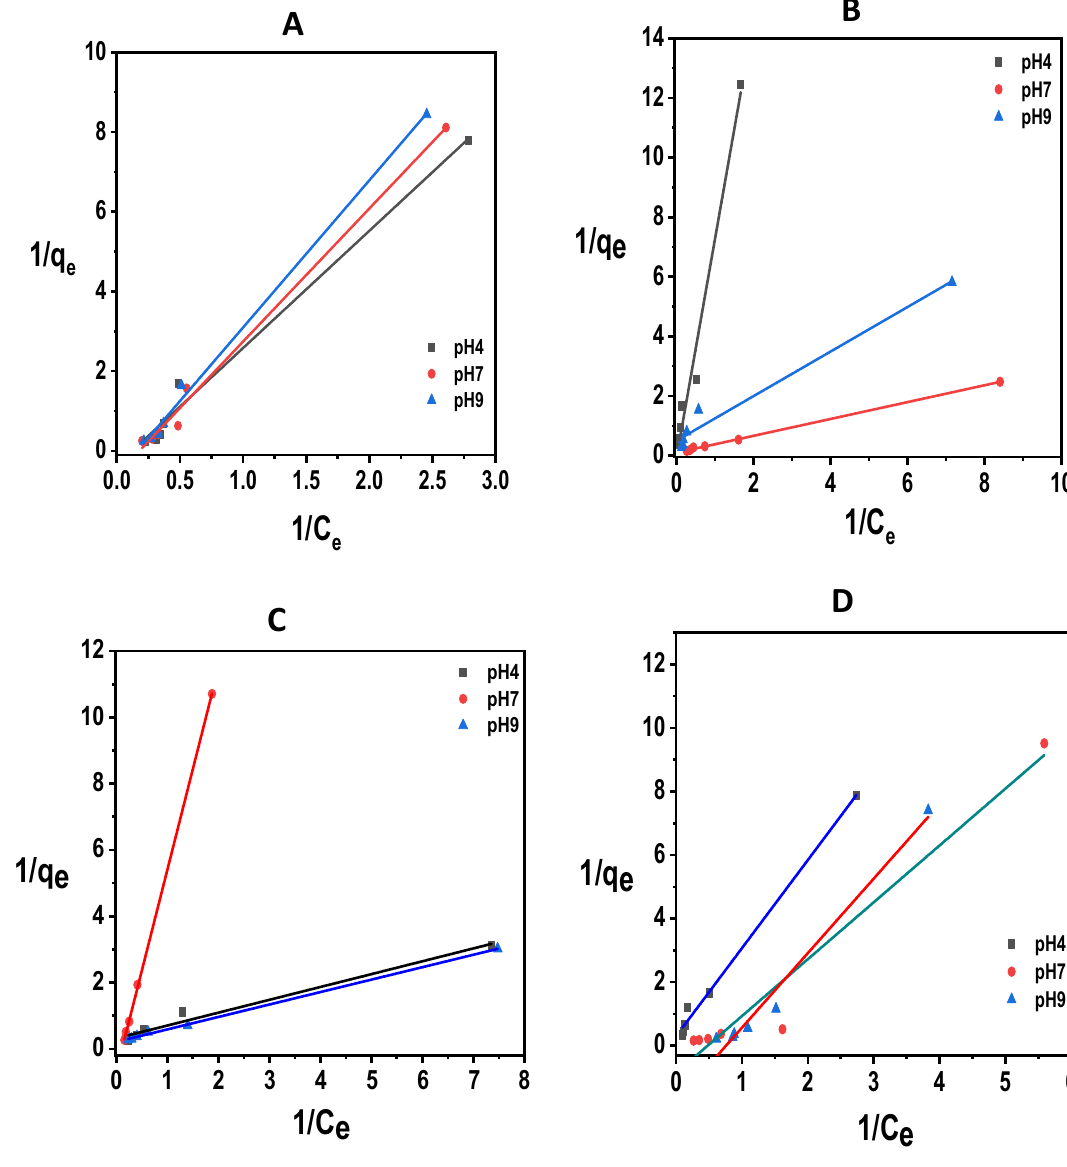
Figure 2. Langmuir isotherms at 27 °C and pHs 4.0, 7.0 and 9.0 for the adsorption of ( A ) diazinon and ( B ) dichlorvos on CDA and for the adsorption of ( C ) diazinon and ( D ) dichlorvos on